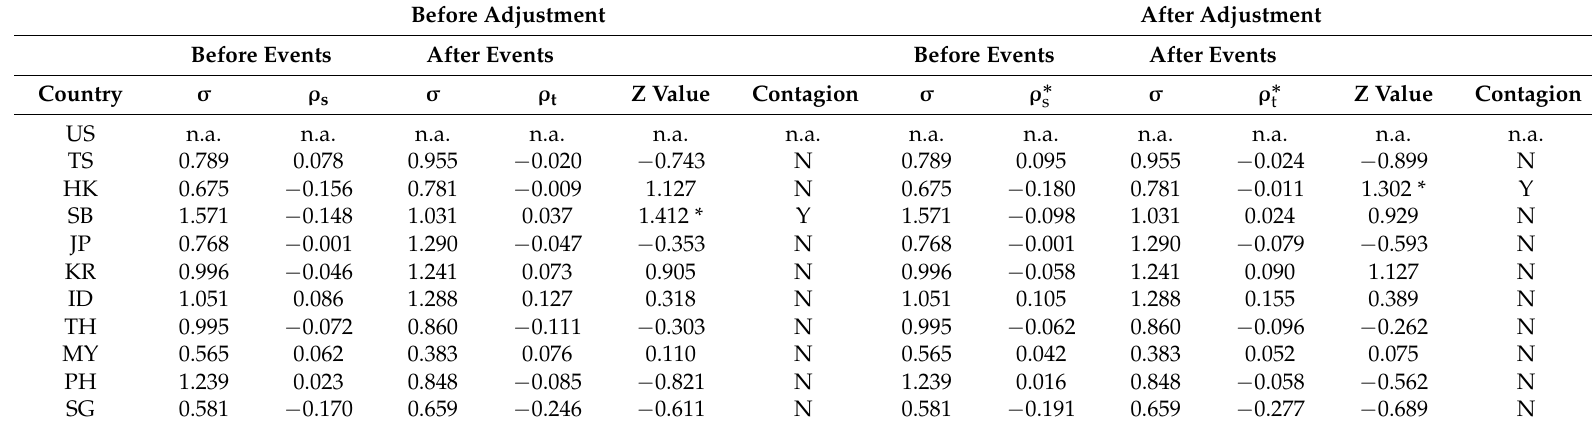
Table 7. The Correlation Coefficients after heteroscedasticity biases adjustment: Hurricane Katrina of the United States. Before Adjustment After Adjustment Before Events After Events Before Events After Events